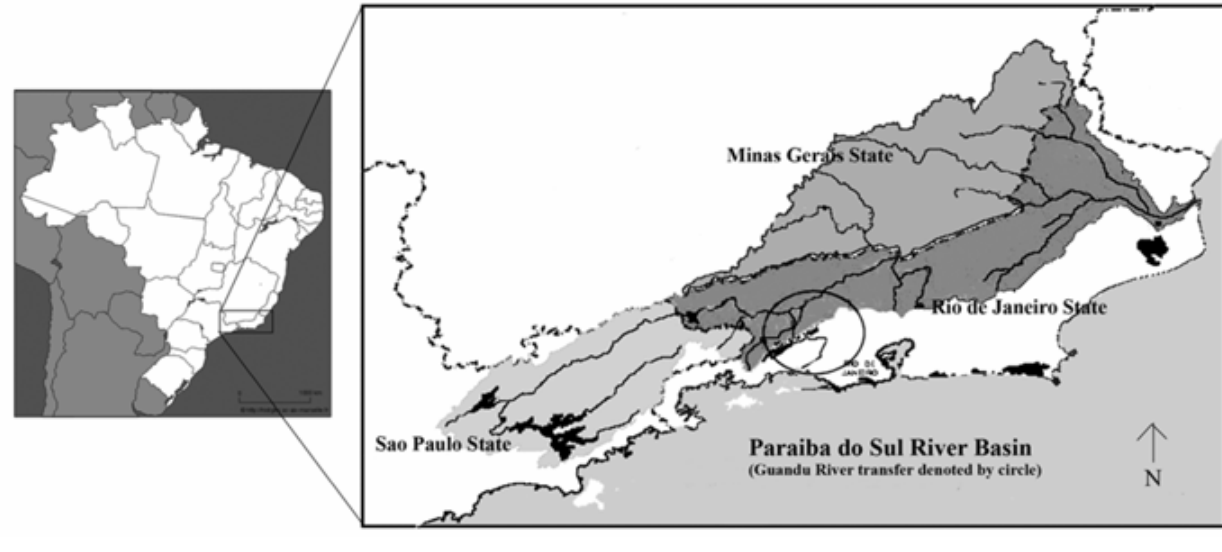
Fig. 3. Paraíba do Sul River Basin. Enlargement shows primary tributaries, reservoirs, and the Guandu River transfer denoted by a circle. (Source: COPPE at the Federal University of Rio de